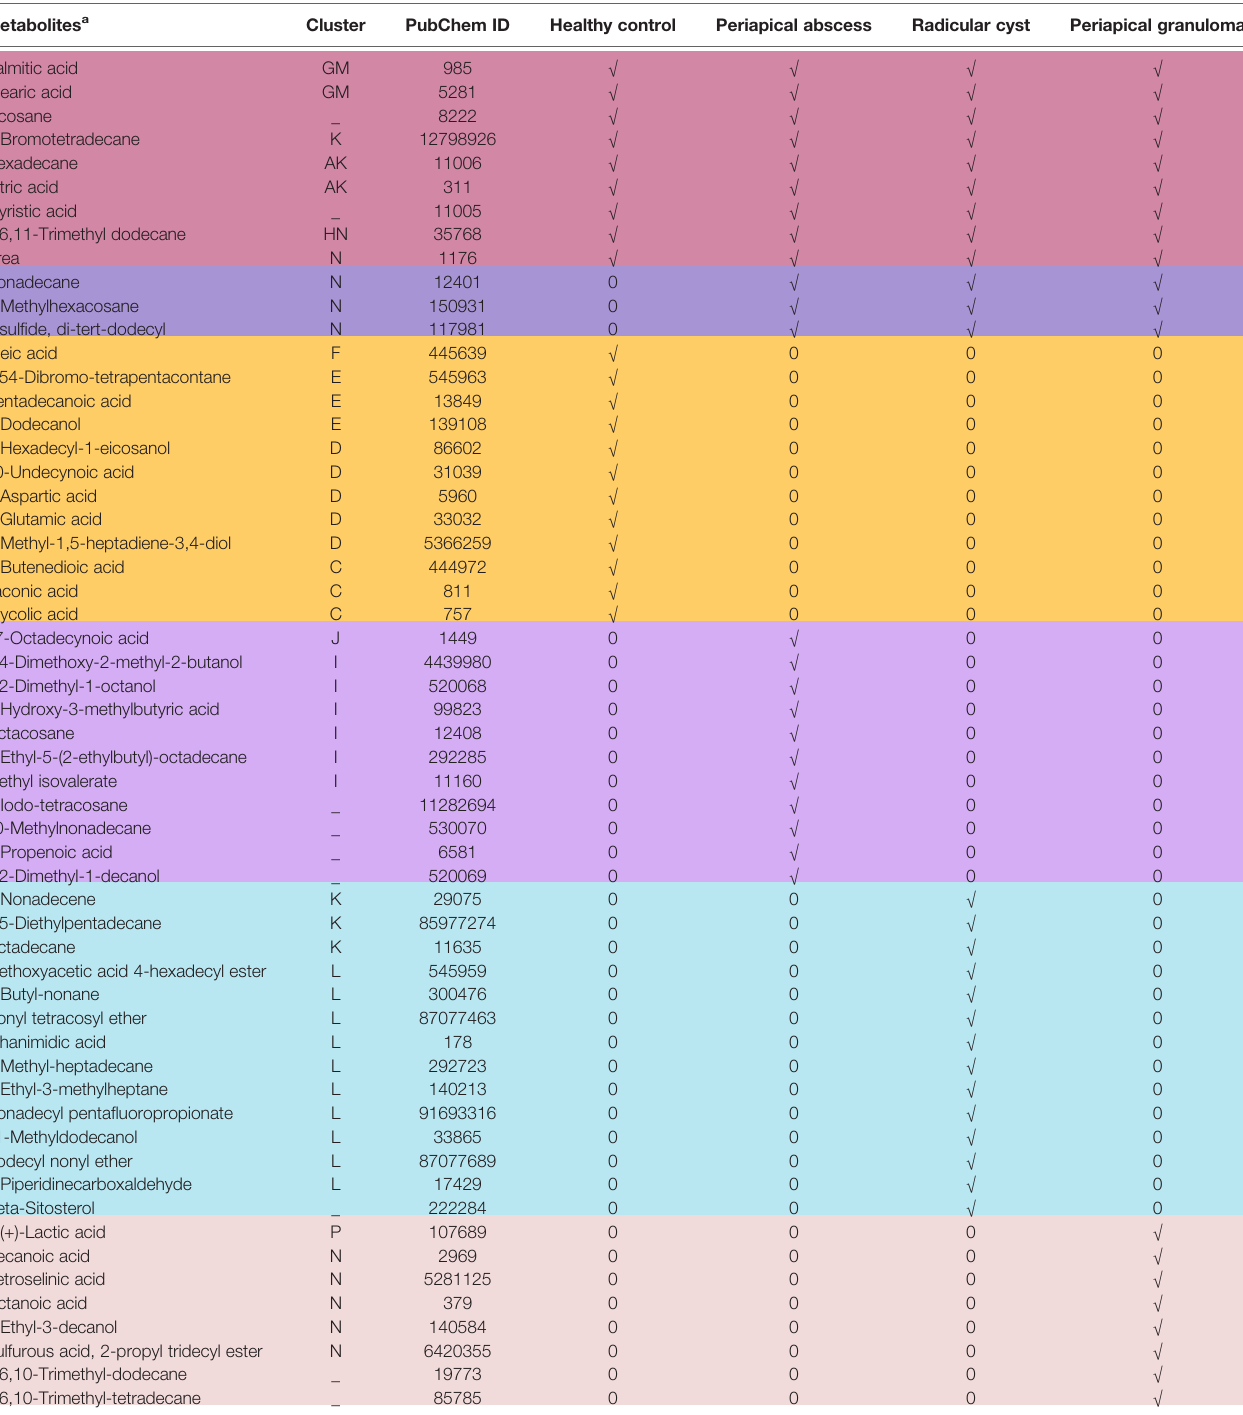
a The colored metabolites are linked to Figure 2A color